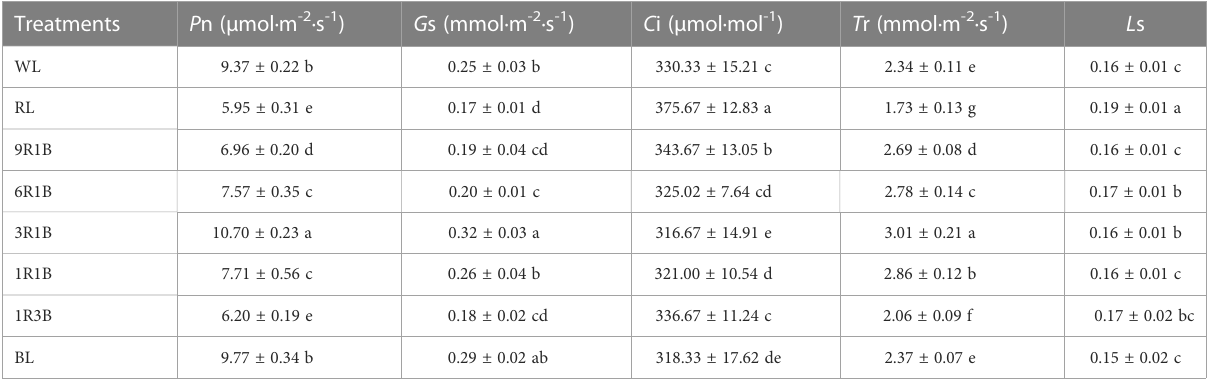
TABLE 2 Effect of monochromatic and mixed red and blue light on gas exchange parameters in sweet pepper seedlings at day 30 after treatment. Treatments